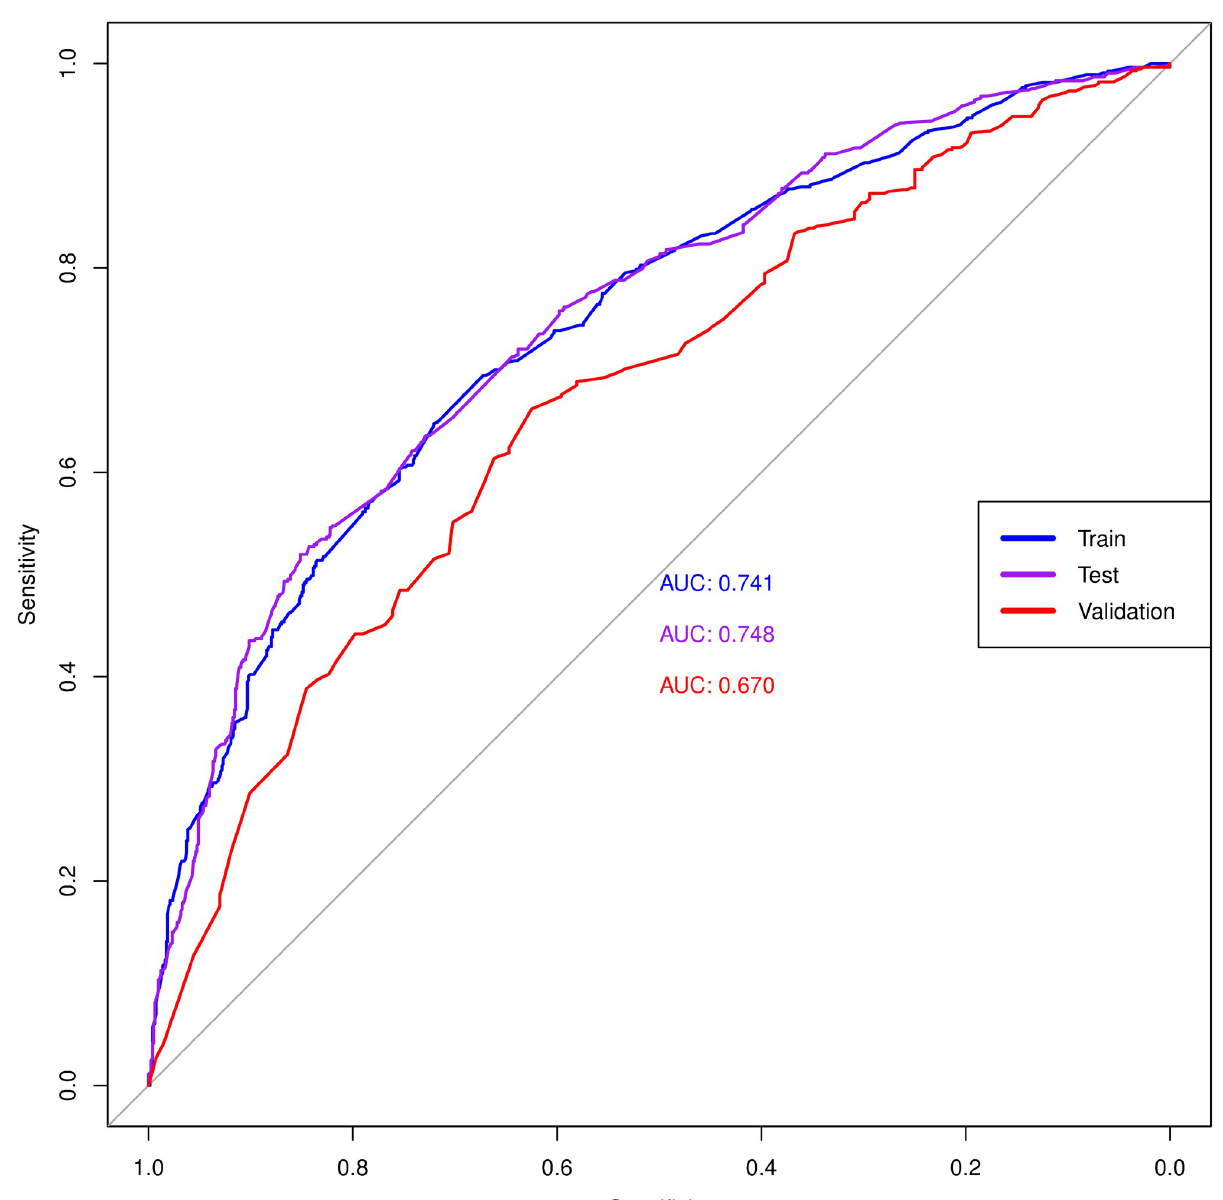
Fig 2. ROC curves. ROC curves for the OAI training and test models, and the MOST validation model. The AUC for each curve is listed on the curve.